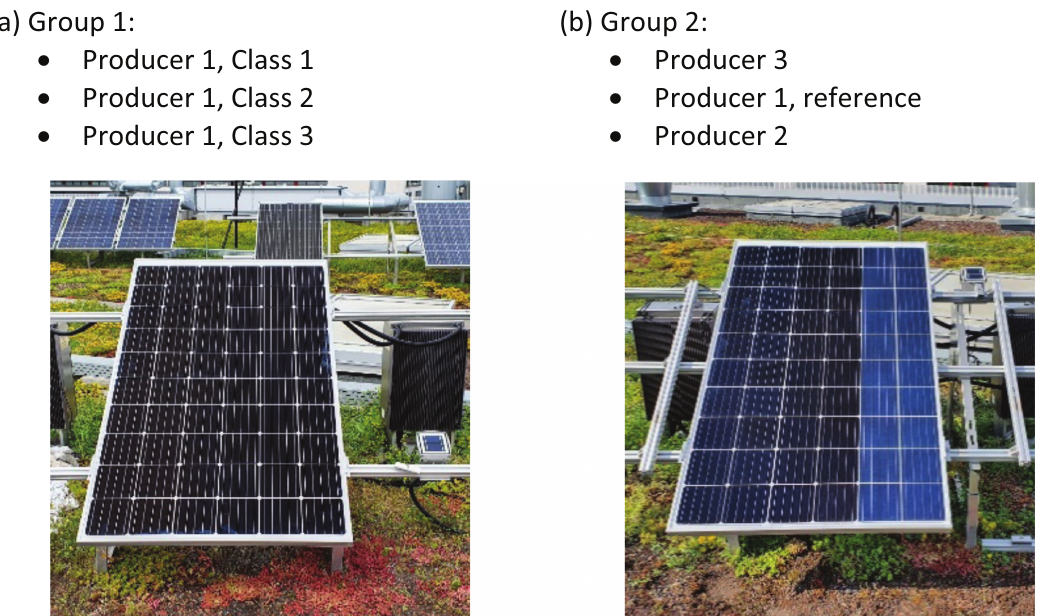
Fig. 3. Photo of outdoor test setup on Fraunhofer CSP rooftop: (a) group 1, (b) group 2.